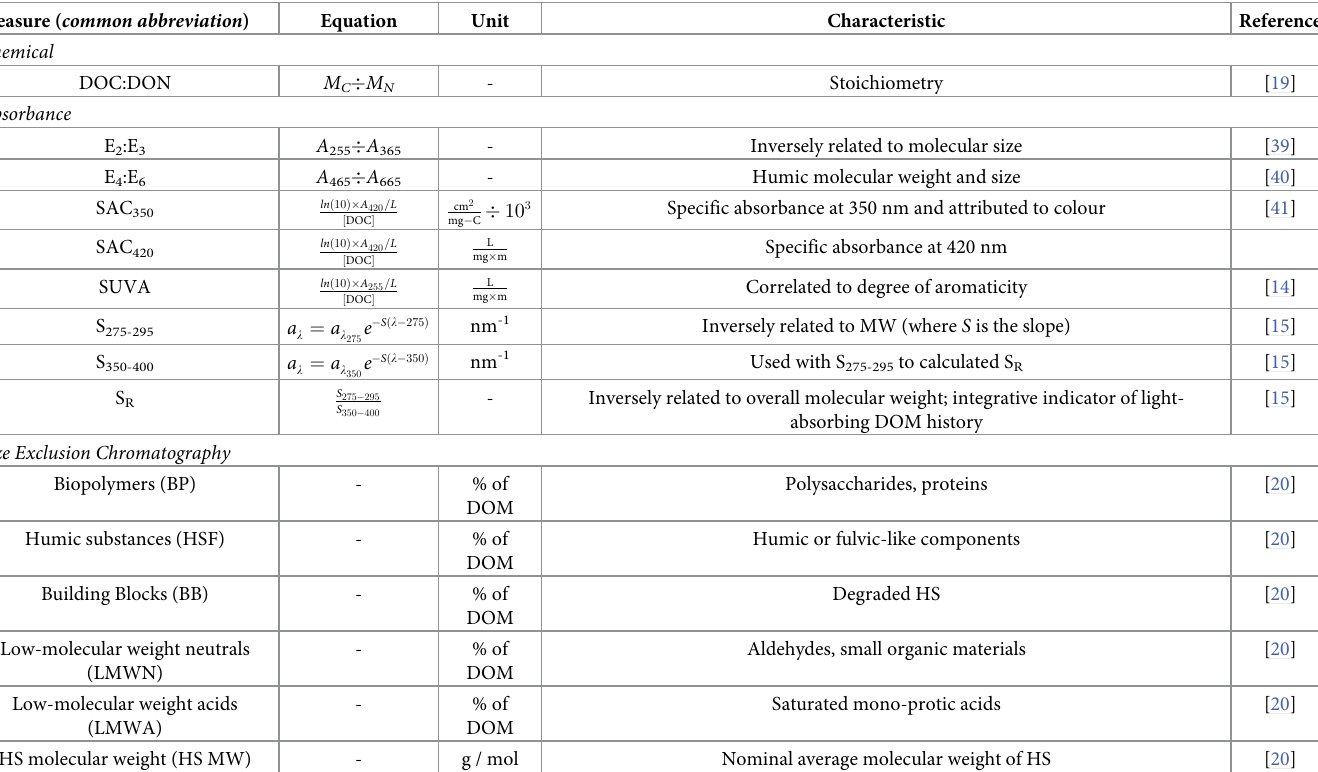
Table 1. Dissolved organic matter composition as described by chemical, absorbance, and molecular-size based measures used in this study.